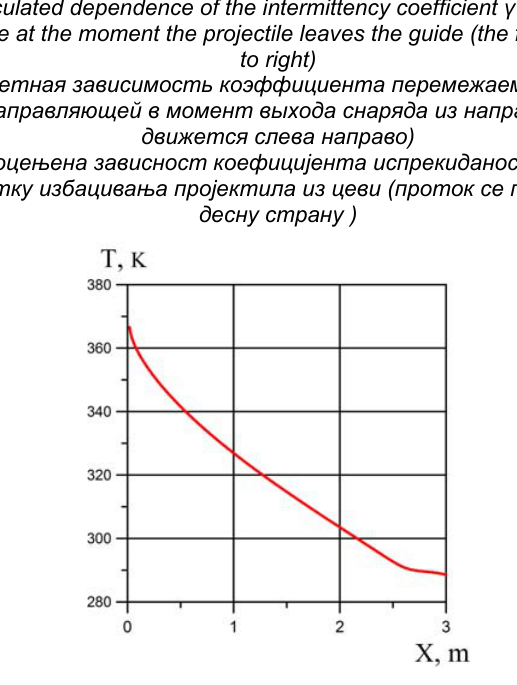
Figure 7 – Calculated dependence for the temperature of the wall T w of the tubular guide along its length at the moment the projectile leaves the guide (the flow moves from right to